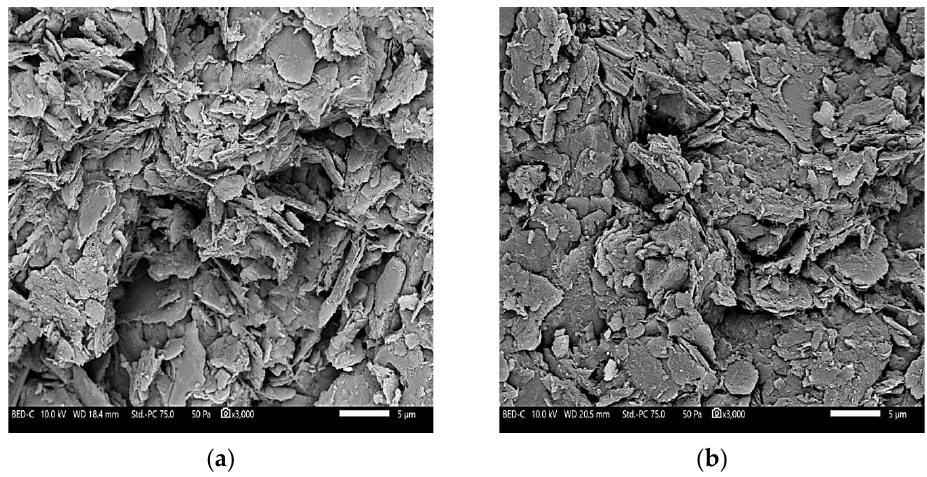
Figure 14. SEM images with 5 µm magnification of ( a ) soil and ( b ) SB soil.